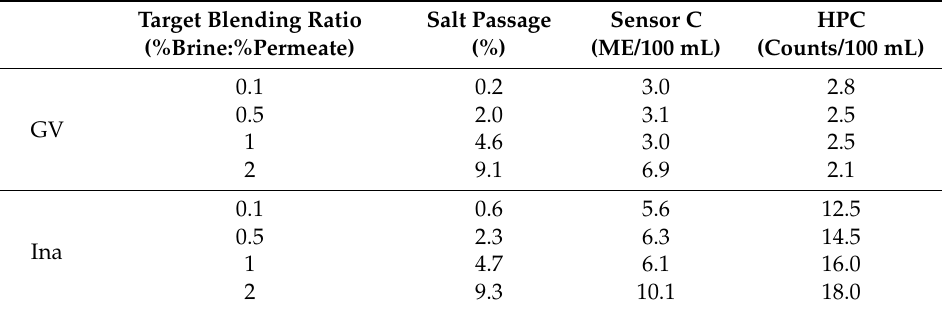
Table 2. Raw microbial counts in blends of Brine: Permeate representing incremental